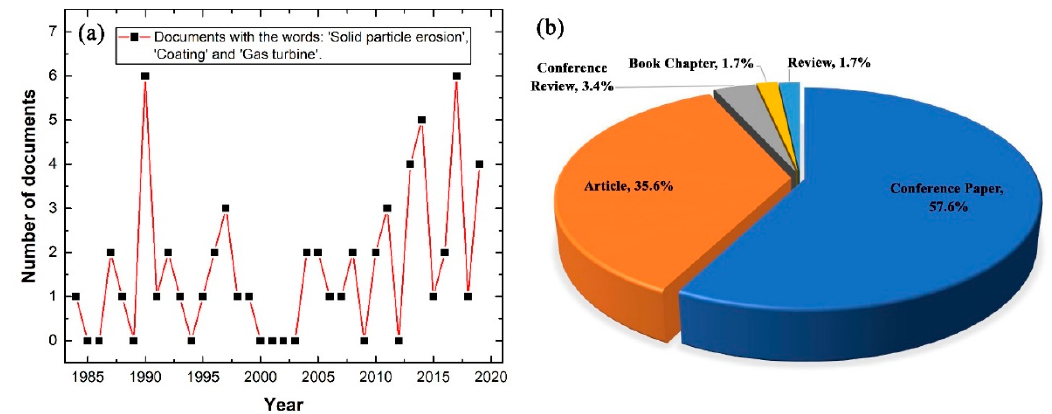
Figure 4. Results from the Scopus database for “Solid particle erosion”, “Coating”, and “Gas turbine” from 1984 to 2019, where ( a ) is publications per year, and ( b ) is the overall percentage for each topic.